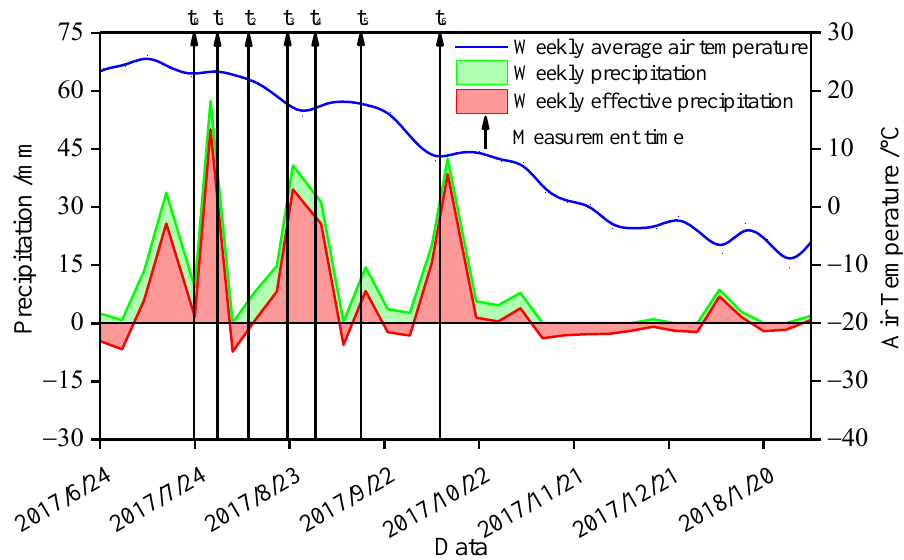
Figure 4. Weekly precipitation, weekly effective precipitation and weekly average temperature measured. The arrows indicate the measurement moments for the six groups of apparent resistivity.